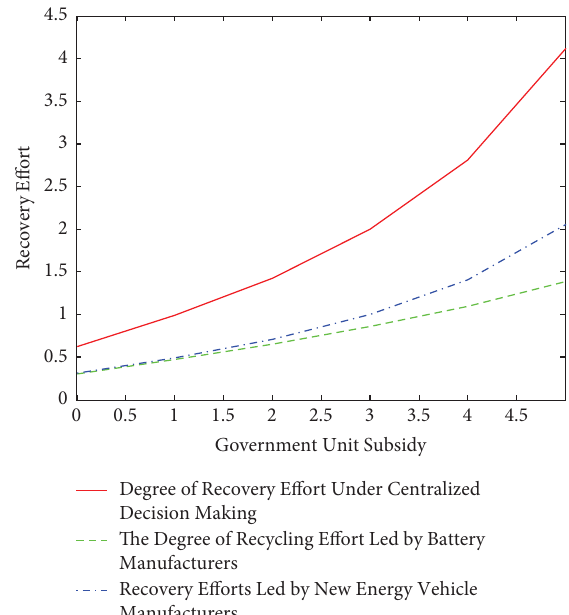
Figure 3: Te infuence of government subsidies on battery re- covery under diferent power structures.